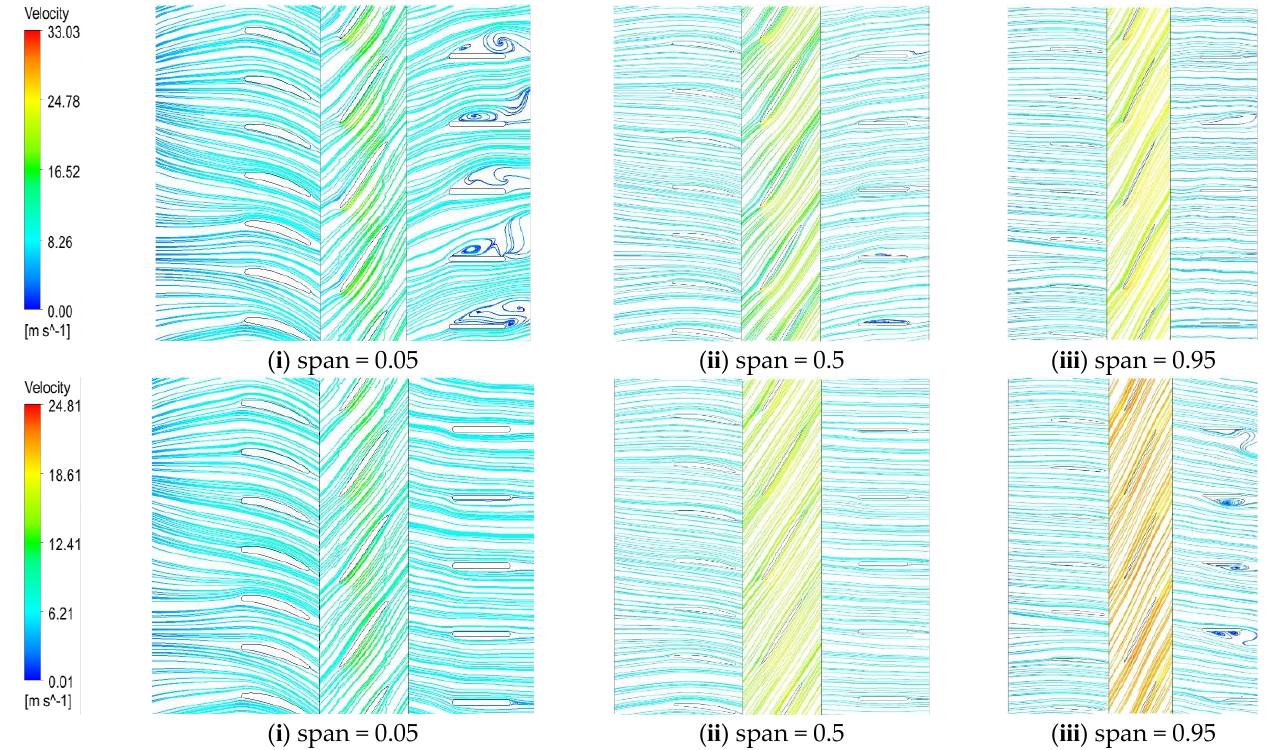
Figure 17. Velocity streamline distribution under turbine condition. ( ⅰ ) span = 0.05. ( ⅱ ) span = 0.5. ( ⅲ ) span = 0.95.